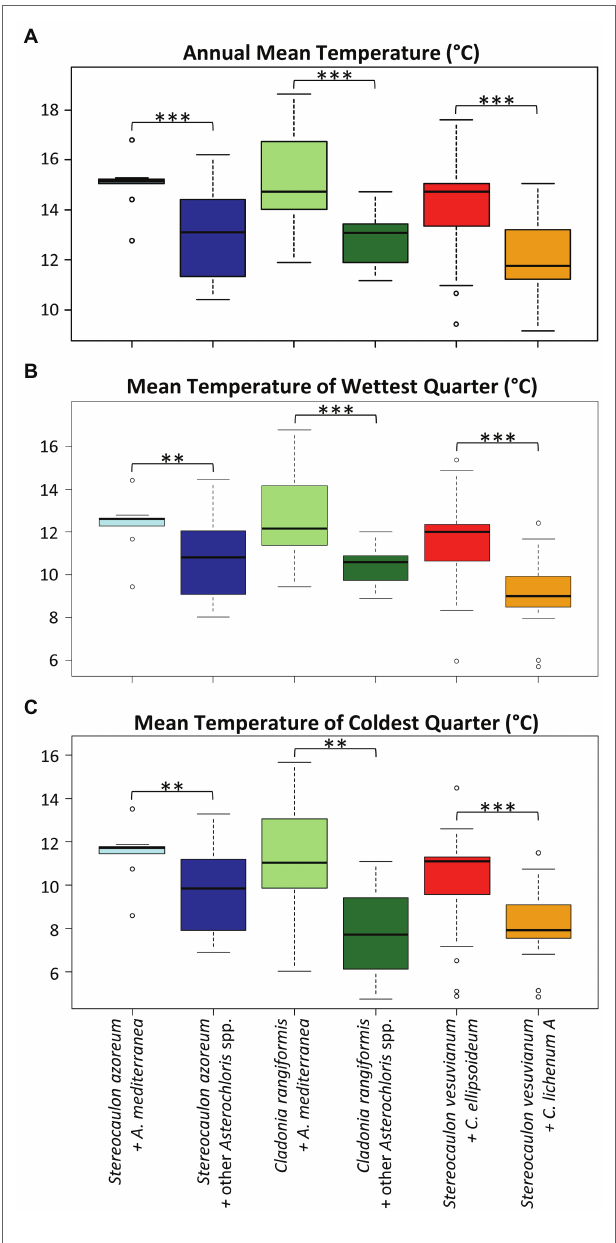
FIGURE 8 | Differences in the distribution of selected phycobiont-mycobiont pairs along the gradients of (A) annual mean temperature, (B) mean temperature of wettest quarter, and (C) mean temperature of coldest quarter. Significance level: two stars ( ** ): p < 0.01, three stars ( *** ): p <